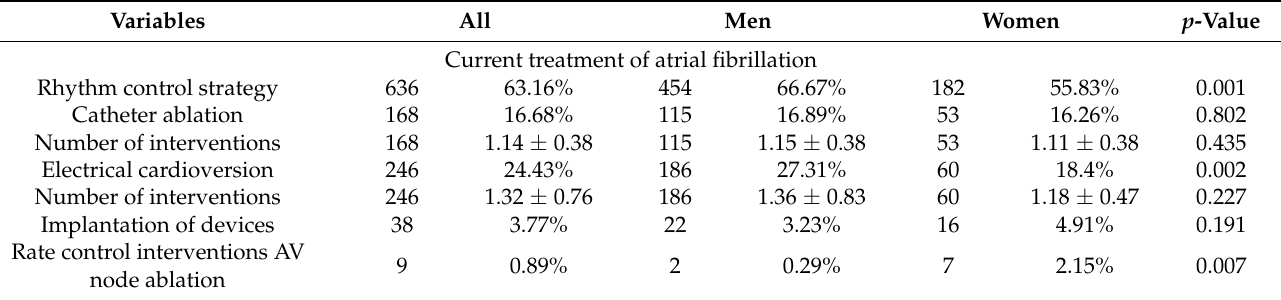
Table 7. Current clinical management strategies.